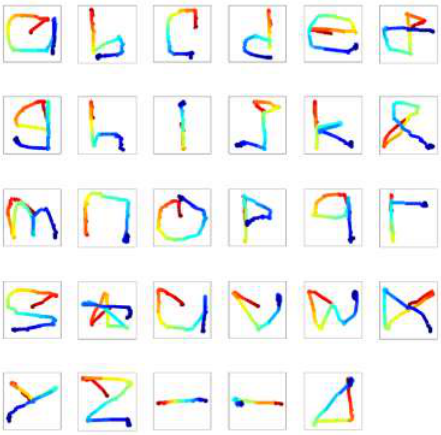
Figure 10. Example of eye-written characters (26 English alphabets and three punctuation symbols). The color of traces indicates the stroke order (from red to blue). Reprinted with permission [11].